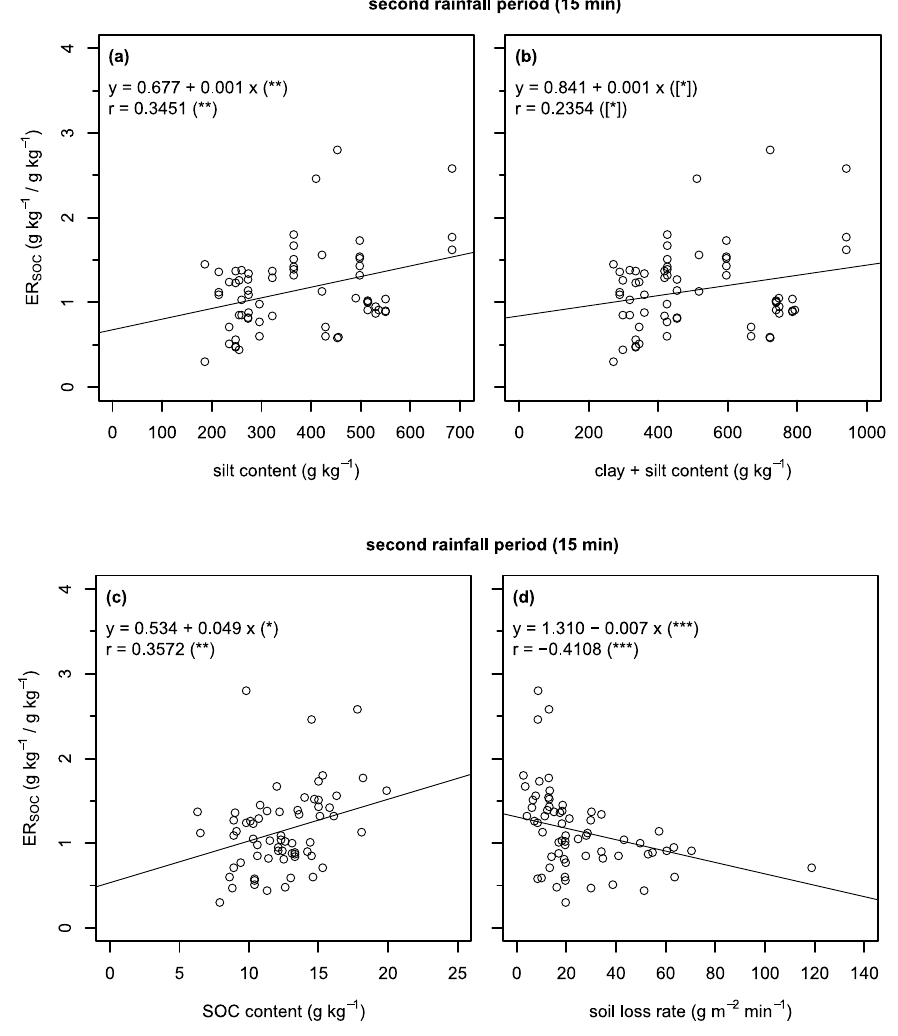
Figure 7. Simple linear regression of the soil organic carbon enrichment ratio (ER SOC ) in the second rainfall period (15 min) against ( a ) the silt content, ( b ) clay + silt content, ( c ) soil organic carbon (SOC) content, and ( d ) soil loss rate. For each parameter fitting, generalised linear models assuming a Gamma distribution have been applied. The regression functions and Pearson product–moment correlation coefficients ( r ) are given for each parameter fitting. The significance levels of the regression function slopes and r , indicating a difference from zero, are as follows: (***) p < 0.001; (**) p < 0.01; (*) p < 0.05; ([*]) p < 0.1.